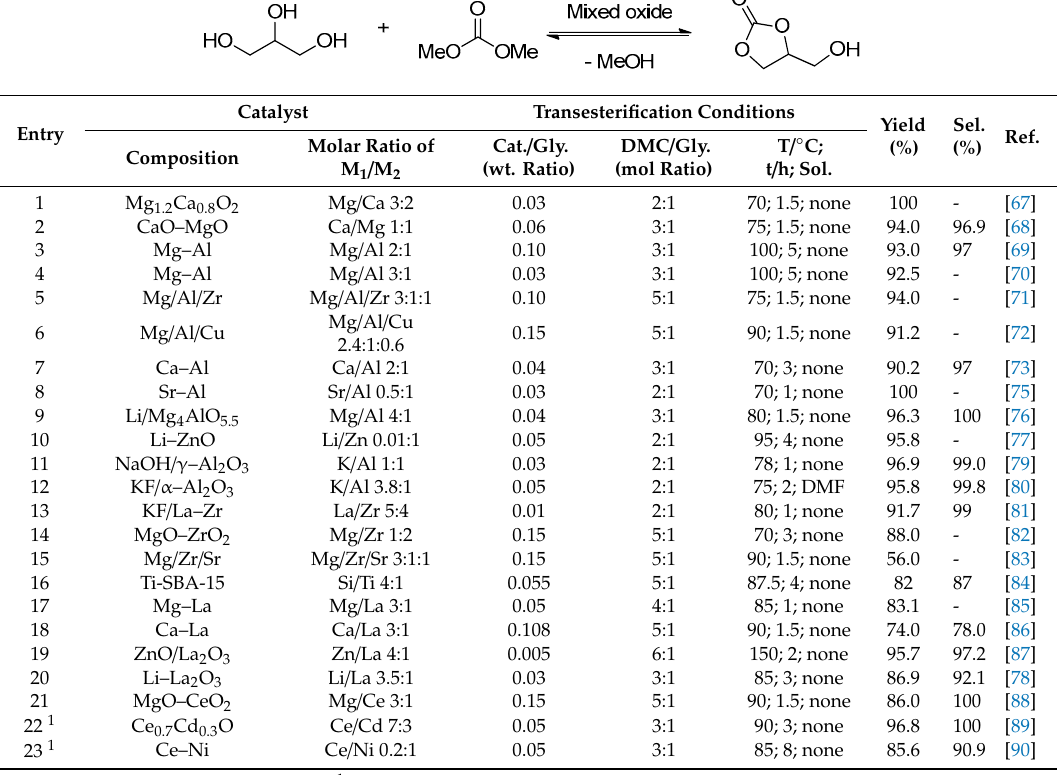
Table 3. Mixed oxides catalyzed transesterification of glycerol.